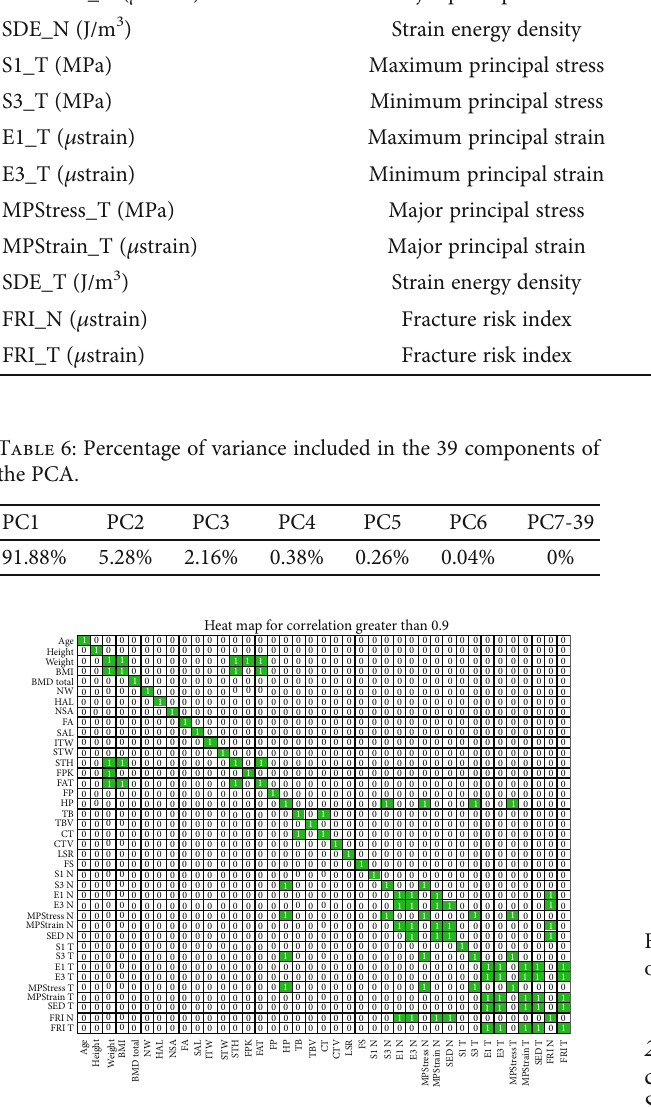
Figure 4: Pearson ’ s correlation: heat map considering a threshold of 0.9. The white zeros represent a correlation lower than the threshold while the coloured ones stand for a correlation equal or higher than 0.9.